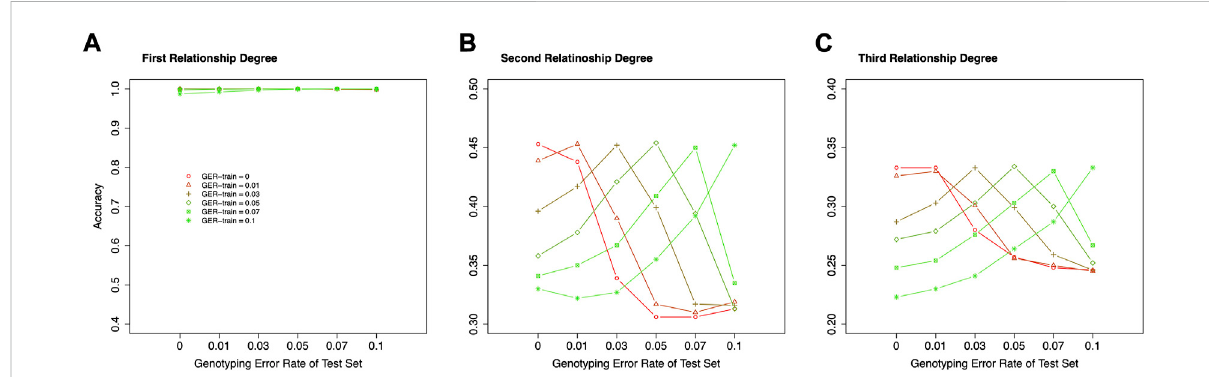
FIGURE 8 Theeffectofgenotypingerrorrateofthetrainingdatasetinrelationshiptypeclassi fi cation. (A) theaccuracieswiththe fi nalselectedfeaturesfor the1stdegreerelationshipsinthetrainingandtestdatasetswithdifferentgenotypingerrorrates, (B) theaccuracieswiththe fi nalselectedfeaturesfor the 2nd degree relationships in the training and test datasets with different genotyping error rates, (C) the accuracies with the fi nal selected features forthe3rddegreerelationshipsinthetrainingandtestdatasetswithdifferentgenotypingerrorrates.Thelabelsofthe x -axis (A – C) representthe differentgenotypingerrorratesofthetestdataset.Thelabelsofthe y -axis (A – C) representclassi fi cationaccuracy.GER-train=genotypingerrorrate of the training